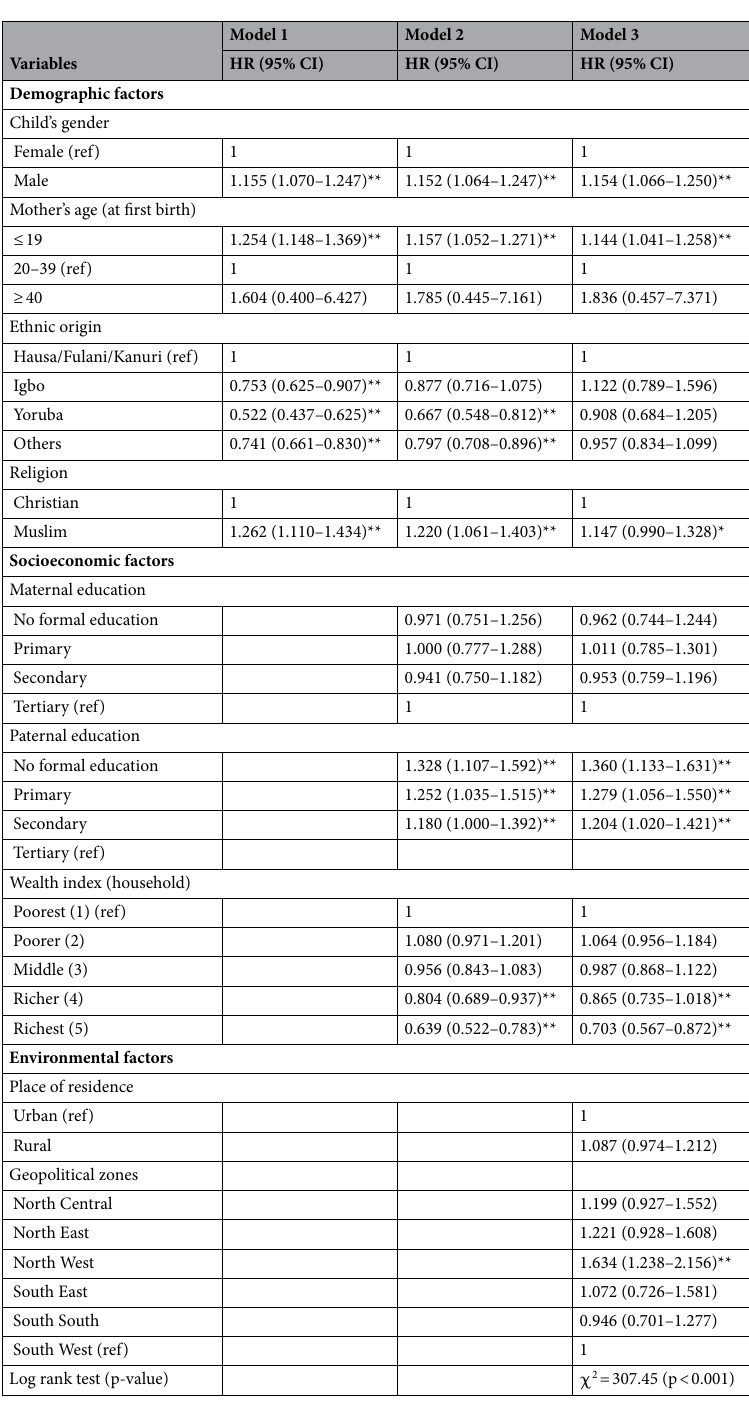
Table 3. The Cox’s proportional hazard ratios (HR) with 95% confidence interval (CI) for factors affecting under-five mortality in Nigeria 2018. **p < 0.05, *p <